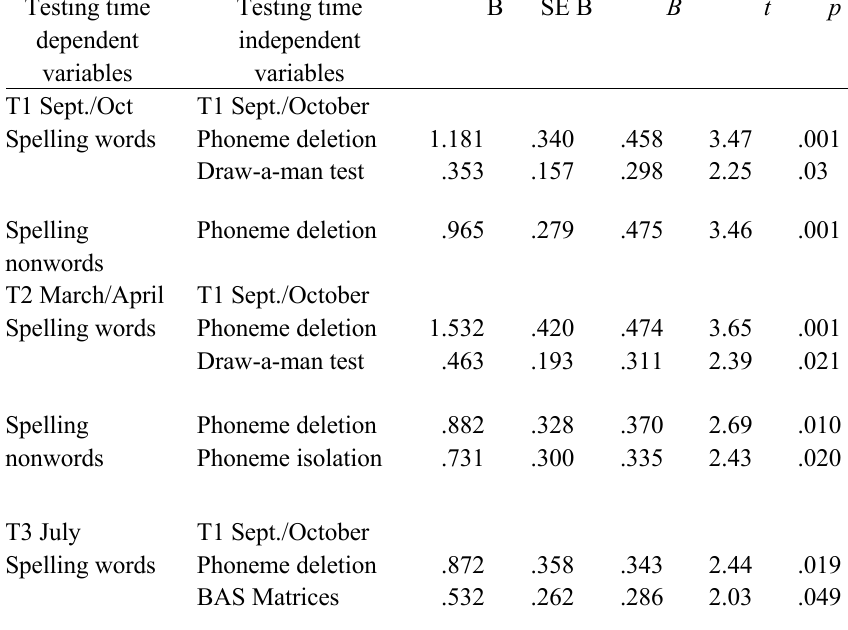
Table 3. Multiple regression analyses predicting spelling at the three testing times with the independent variables from testing time 1 – Monolinguals Testing